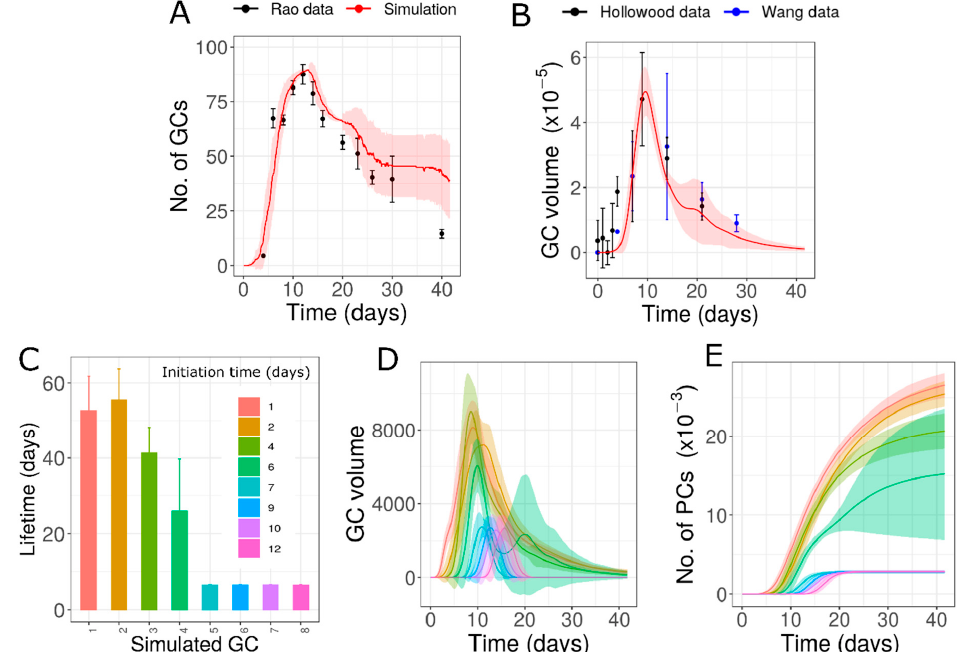
Figure 5. Simulations of GCs with multiple epitopes and different founder cell specificities: ( A ) dynamics of number of GCs, ( B ) dynamics of total GC volume, ( C ) lifetime of simulated GCs, ( D ) GC volume of individual GCs simulated, ( E ) plasma cells produced from simulated GCs. In Panels C, D and E, GCs initialized at different time points are shown in different colors. Experimental data from [13,31,45]. GC: germinal center; PC: plasma cell.